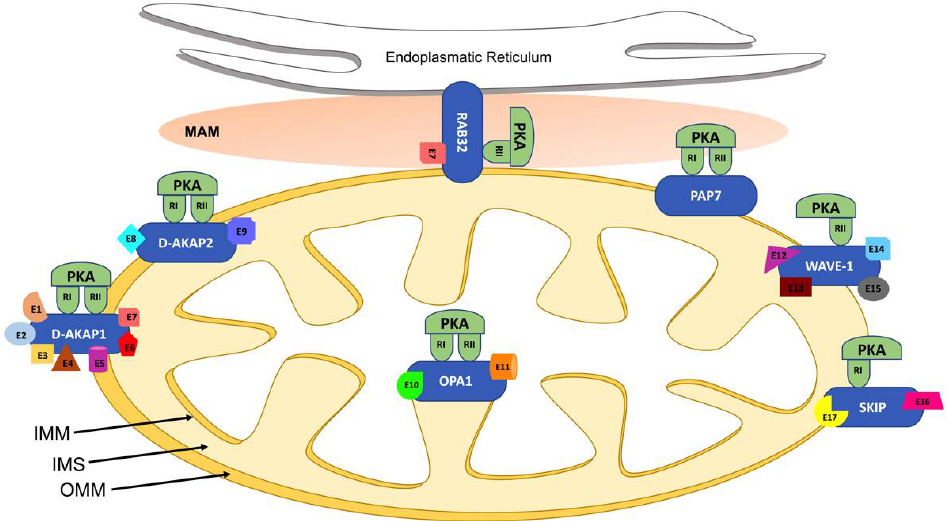
Figure 1. Mitochondrial AKAPs localization. Schematic representation of mitochondrial AKAPs localization as discussed in the text. Abbreviations used: endoplasmic reticulum, ER; intermembrane space, IMS; outer mitochondrial membrane, OMM; inner mitochondrial membrane, IMM; mitochondria-associated membranes, MAM; different binding effectors partners, E.